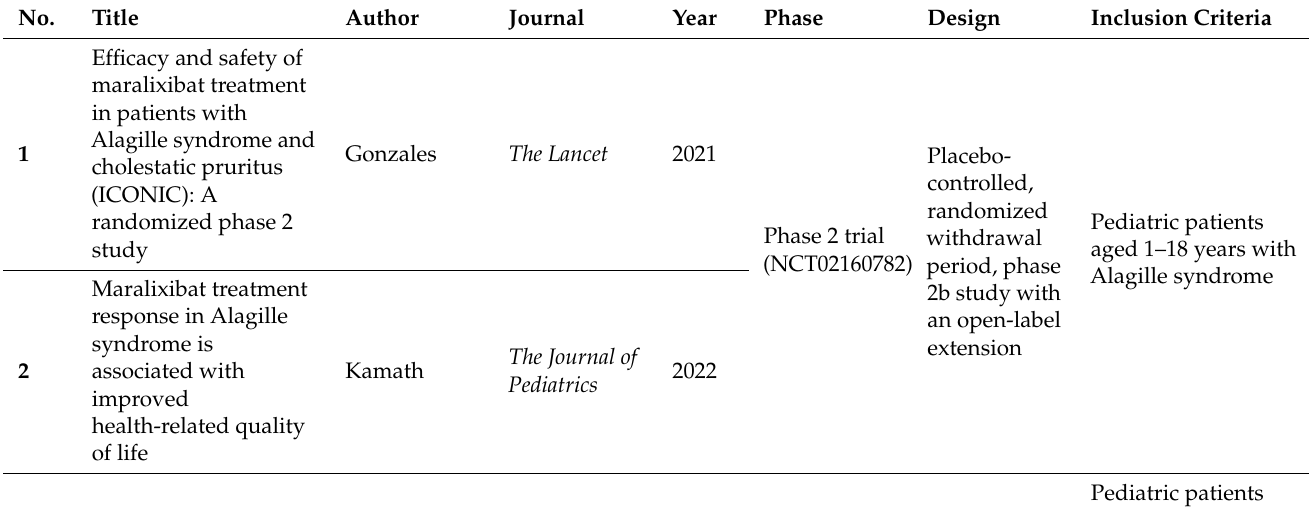
Table 1. Baseline characteristics of the included